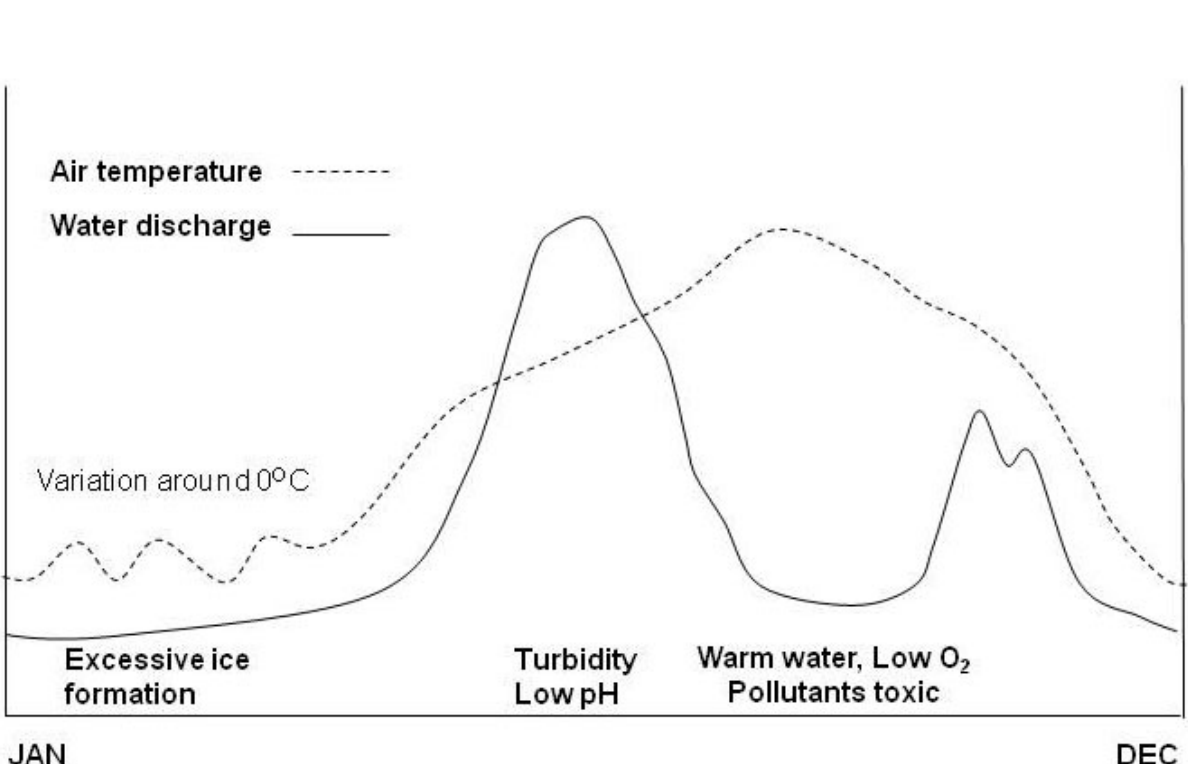
Fig. 1. Annual variation in air temperature and discharge (hypothetical daily values) in a stream with a nival discharge regime. Three situations are highlighted during which discharge and water quality produce combinations that may impair biota. All these situations may occur under natural conditions, but human intrusion can worsen them and exacerbate their environmental